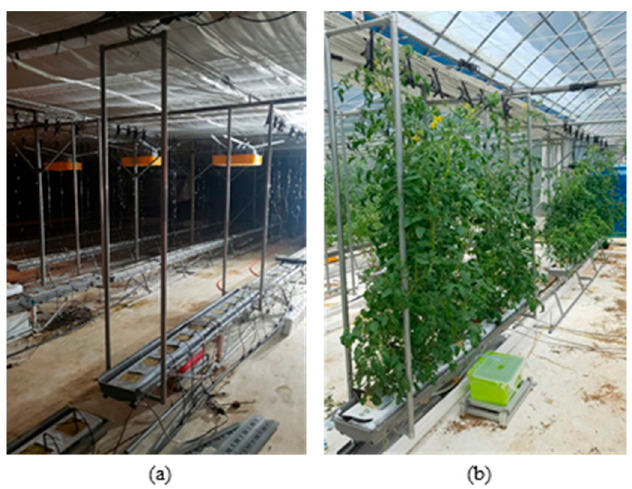
Figure 4. Schematic diagram of self-manufactured system time-dependently measuring ET of tomato crops inside the greenhouse.